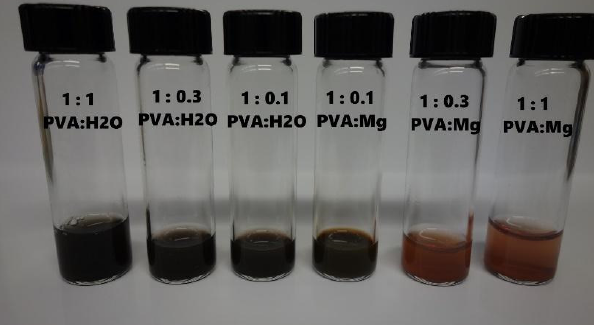
Figure 5. Visual depiction of PVA–water and PVA–salt solutions in order of increasing salt concentration from left to right.